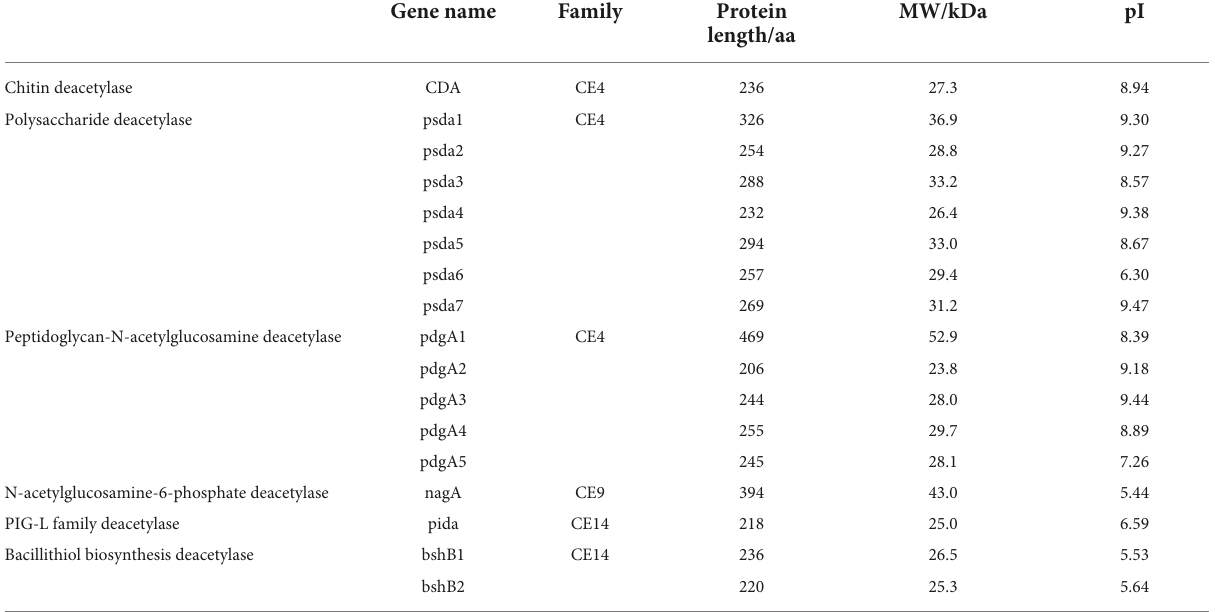
TABLE 2 List of the deacetylase-related proteins identified in the B. aryabhattai TCI-16 genome. Gene name